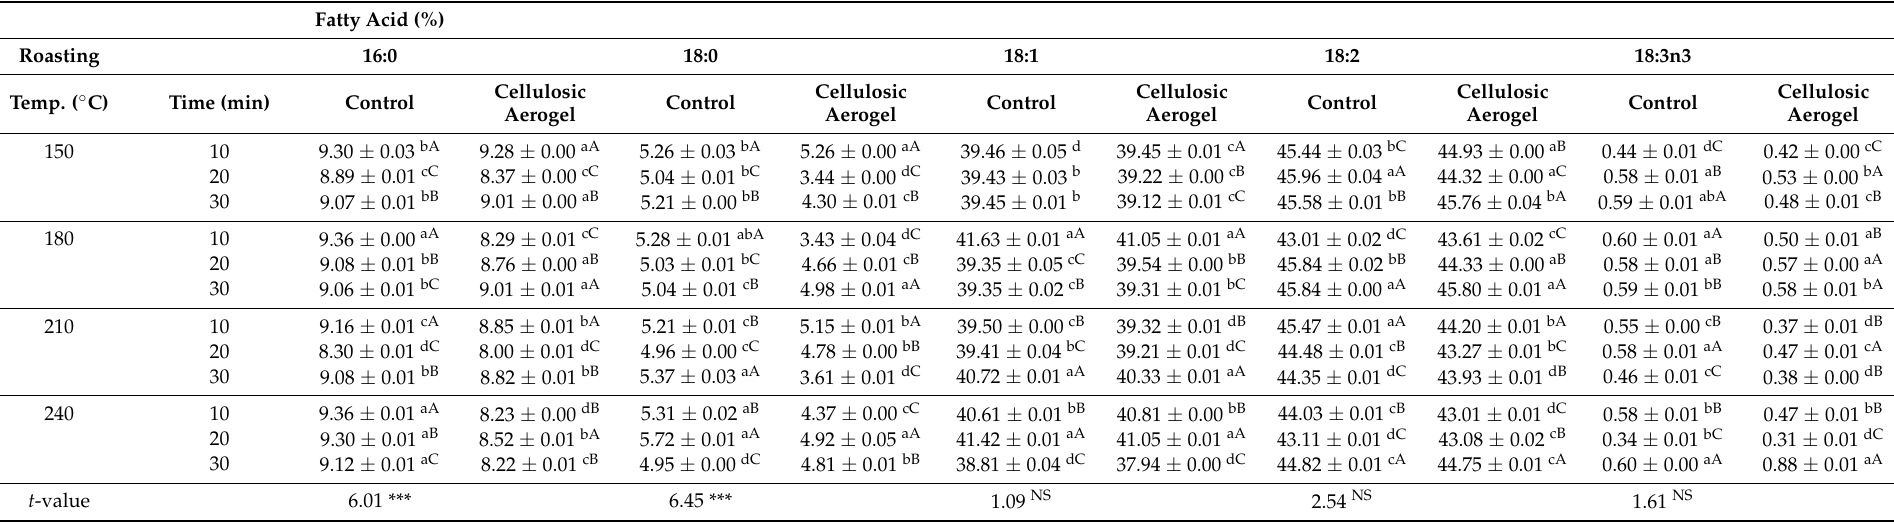
Table 3. Fatty acid compositions of sesame oil without (control) and with cellulosic aerogel